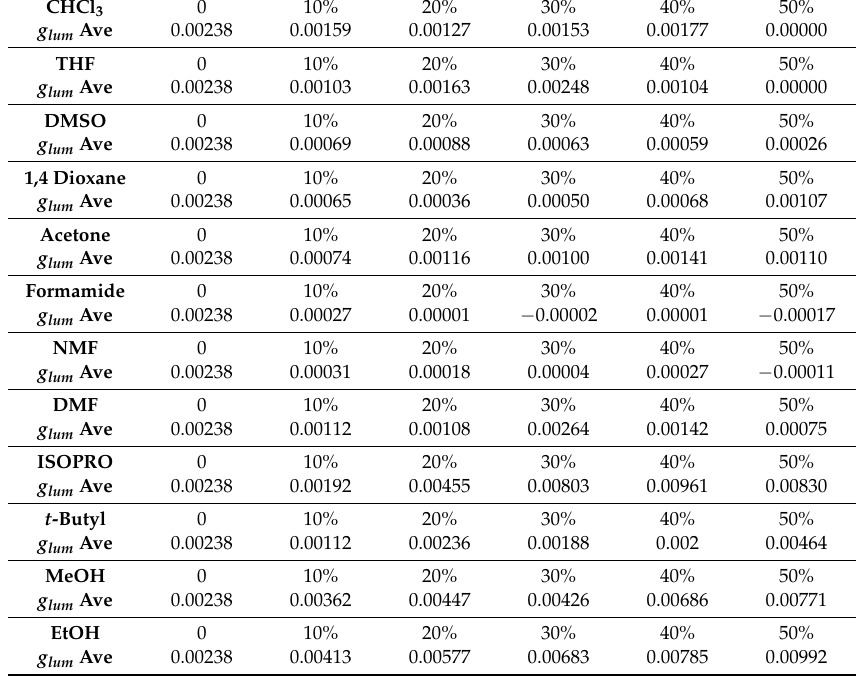
Table 8. Luminescence dissymmetry ratio values ( g lum ) for [Tb(DPA) 3 ] 3 − with 40 equiv. L -Proline in varying ratios of H 2 O:organic solvent.